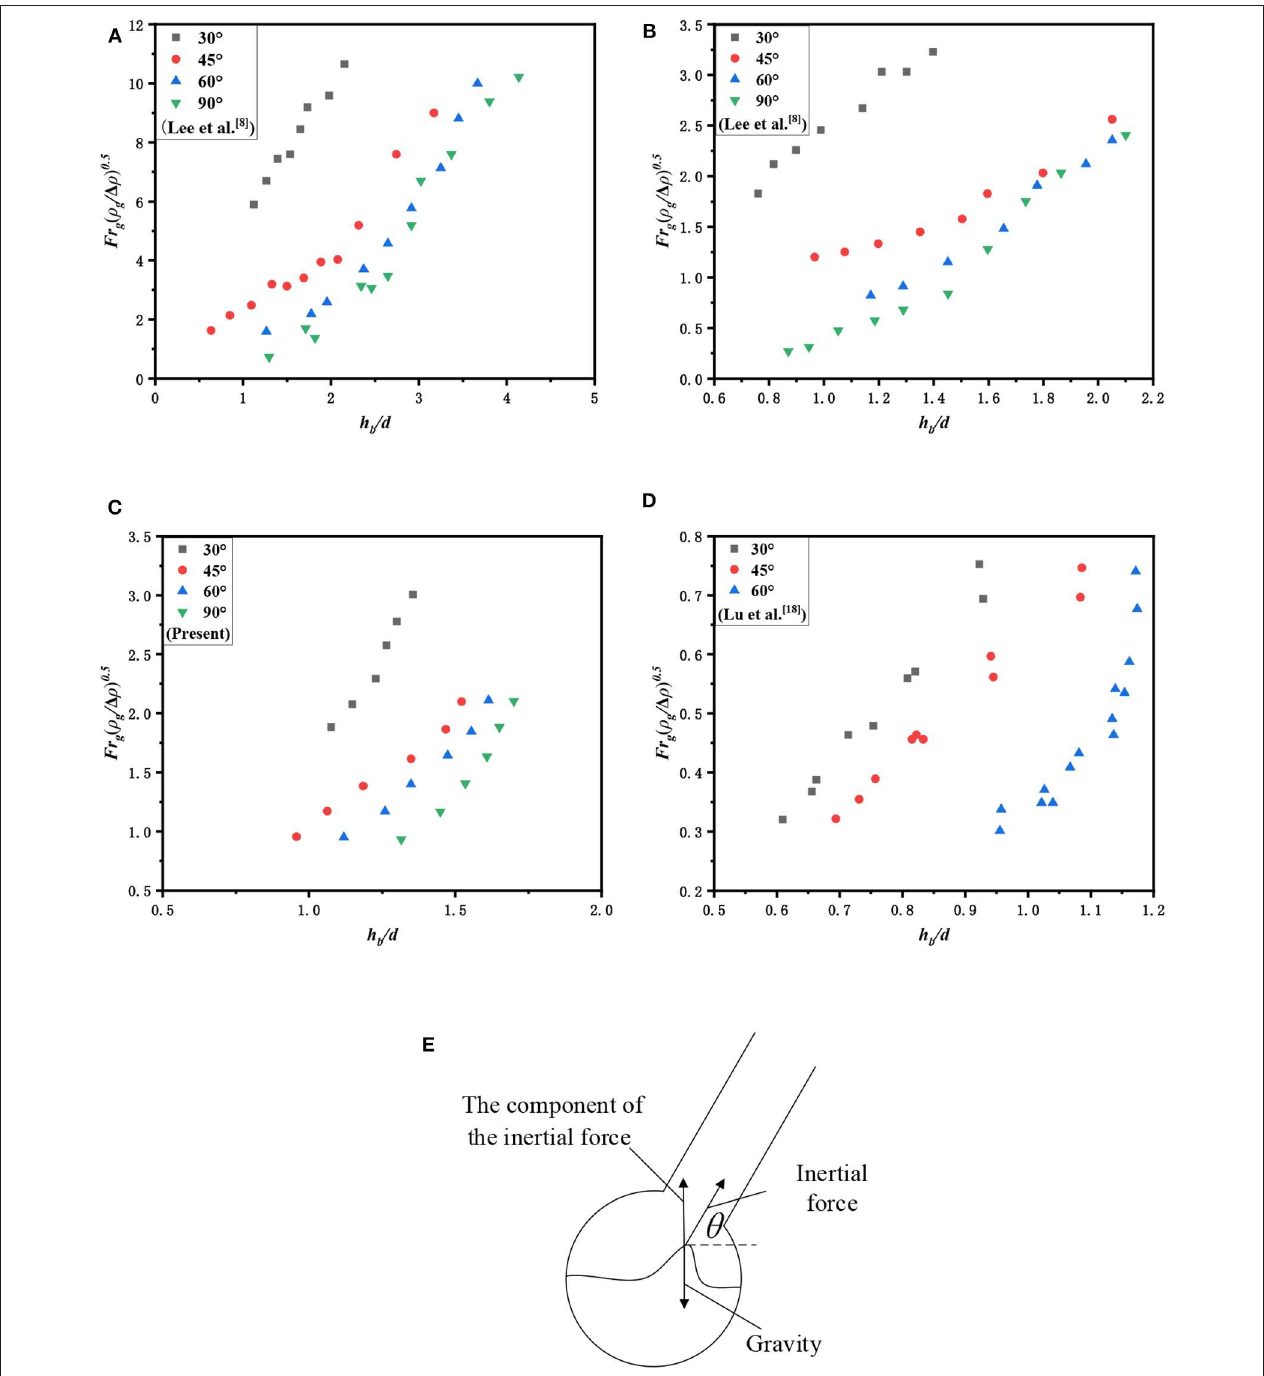
FIGURE 2 | Comparison of entrainment onset data at different branch angles (Lee et al., 2007; Lu et al., 2018) (A) d (D) d 56mm (E) diagram of force =